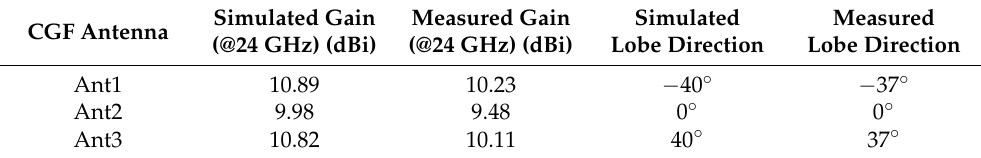
Table 2. Comparison of simulated and measured gain and